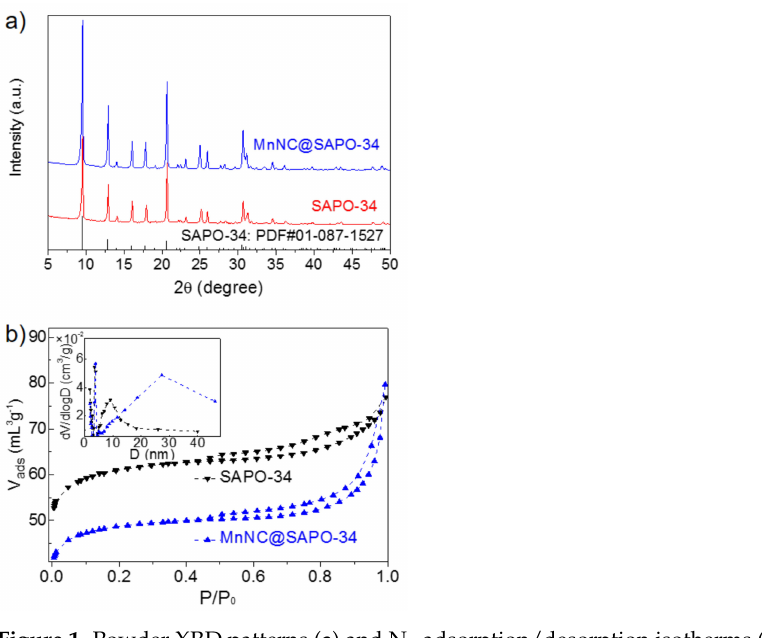
Figure 1. Powder XRD patterns ( a ) and N 2 adsorption/desorption isotherms ( b ) of SAPO-34 silicoa- luminaphosphates and MnNC@SAPO-34 samples. Inset in ( b ): Pore-size